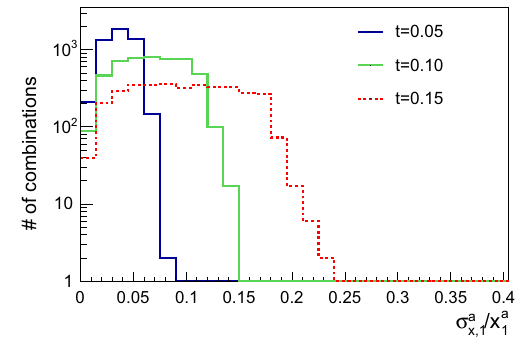
Fig. 9 Relative total uncertainty of the pseudo-measurement a for dif- ferent values of the threshold t for systematic uncertainties. All pseu- do-measurements comprise one relative and two absolute uncertainties depicted either. Different choices for x α μ were tested and con- firm a good modelling with respect to d